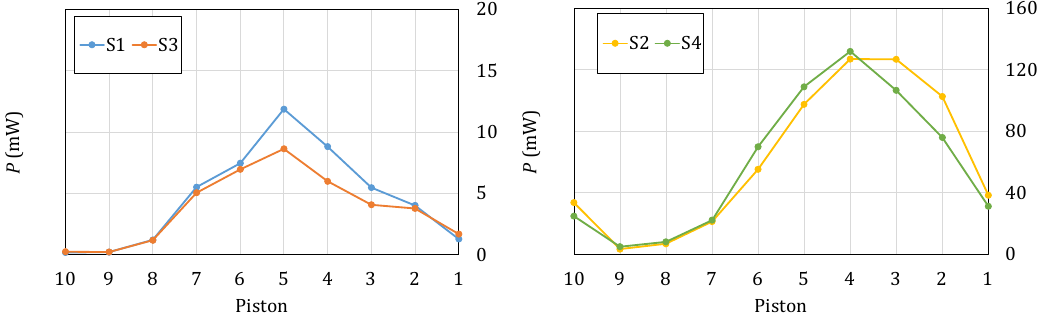
Figure 10. Performance (power per single piston in mW) of the experimental flexible floater device. Left panel: configurations S1 and S3; Right panel: configurations S2 and S4. The incident wave is coming from the right. Connecting lines are for graphical illustration purposes.